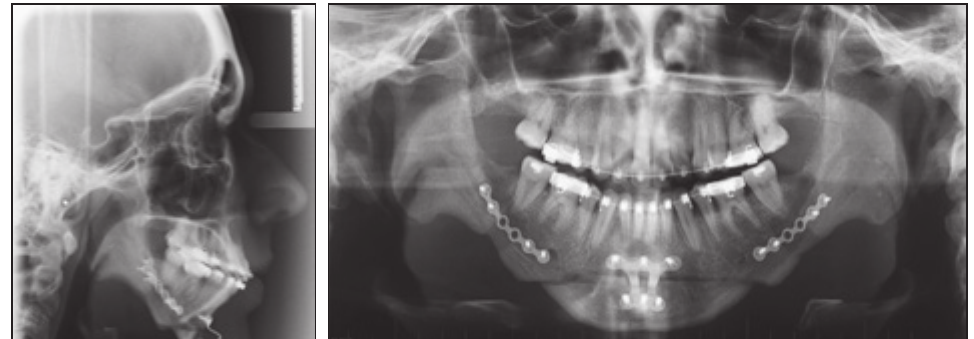
Figure 9. Lateral cephalogram post- Figure 10. Orthopantomogram post-orthognathic surgery; April 2019. orthognathic surgery; April 2019.